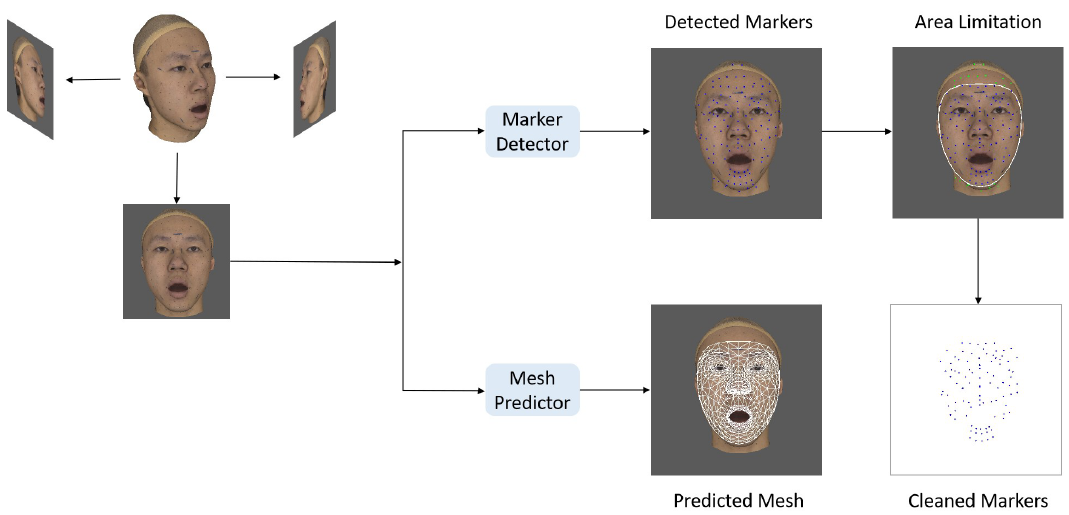
Figure 2. Overview of